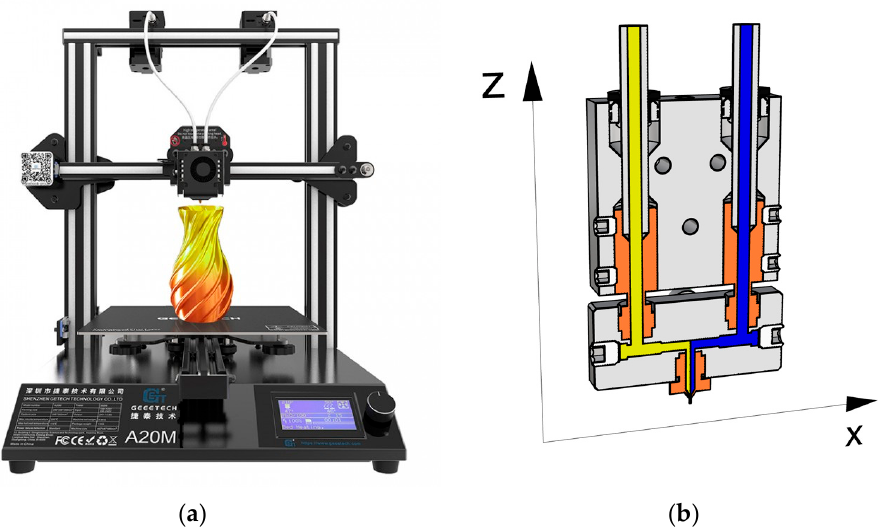
Figure 8. ( a ) The Geeetech A20M Dual Extruder. ( b ) CAD model adapted from GrabCAD [42] of the Cyclops hot-end representation.